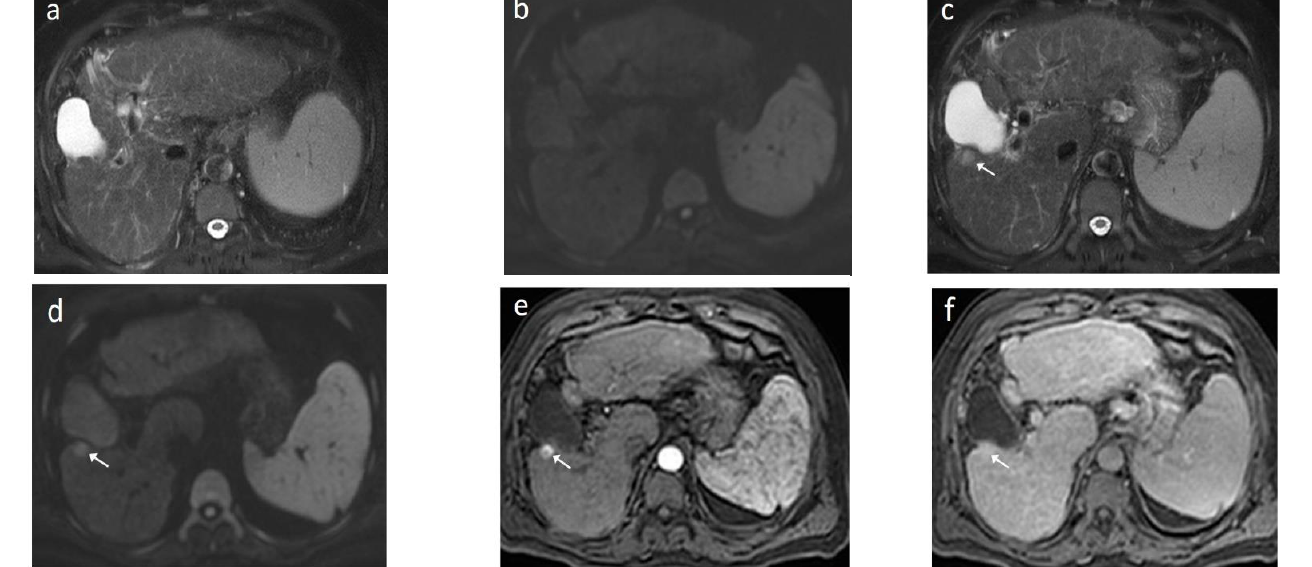
Figure 10. Evolution of a cirrhotic nodule into HCC. No suspicious lesions are identified on the T2 ( a ) and DWI ( b ) sequence of this 66-year-old man with cirrhosis due to hepatitis B infection. On follow-up scan, performed 3 months later, increased T2 signal ( c ) is now observed in a nodule in segment V, which is associated with diffusion restriction (arrow) ( d ). After contrast administration, arterial enhancements ( e ) without delayed wash-out ( f ) are seen; absence of wash-out is frequent in early HCCs.